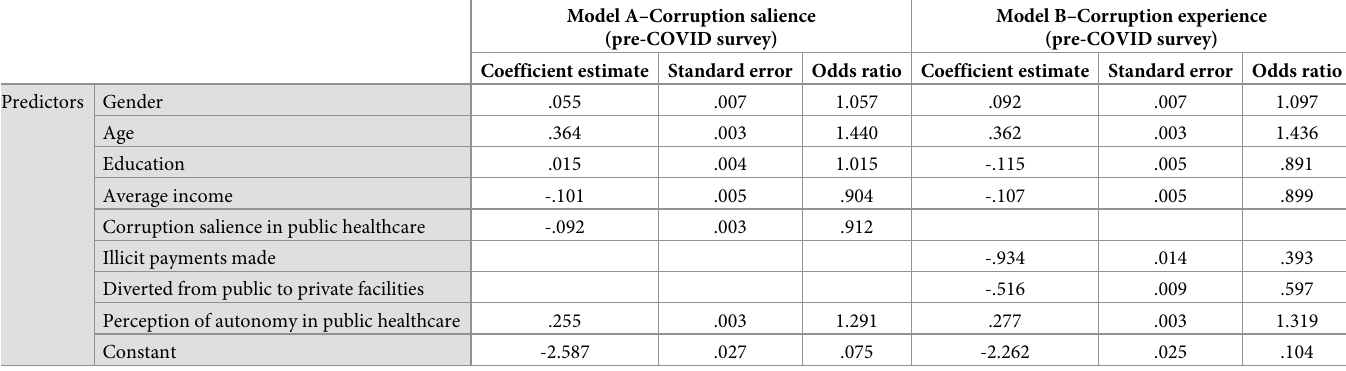
Table 3. Logistics regression results for the pre-COVID